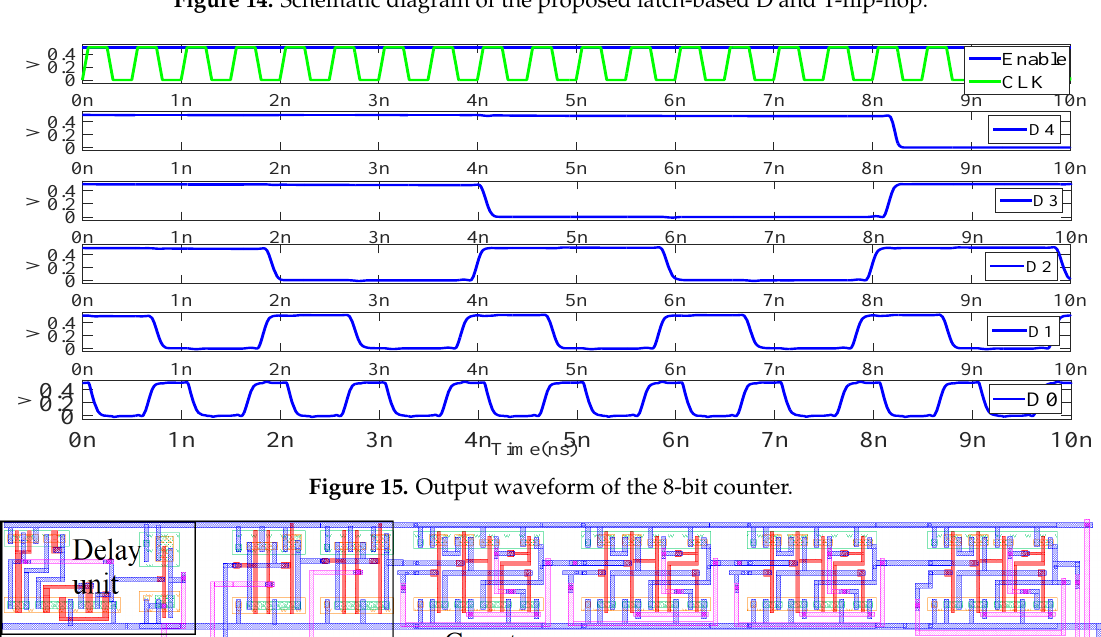
Figure 14. Schematic diagram of the proposed latch-based D and T-flip-flop.